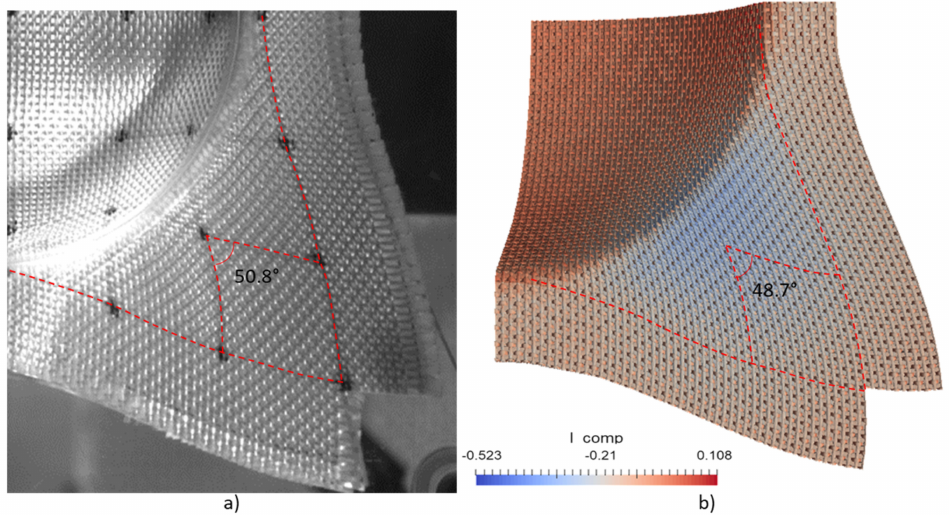
Figure 6. Hemispherical stamping. ( a ) Deformed geometry in experimental result. ( b ) Compaction of yarns in mesoscopic